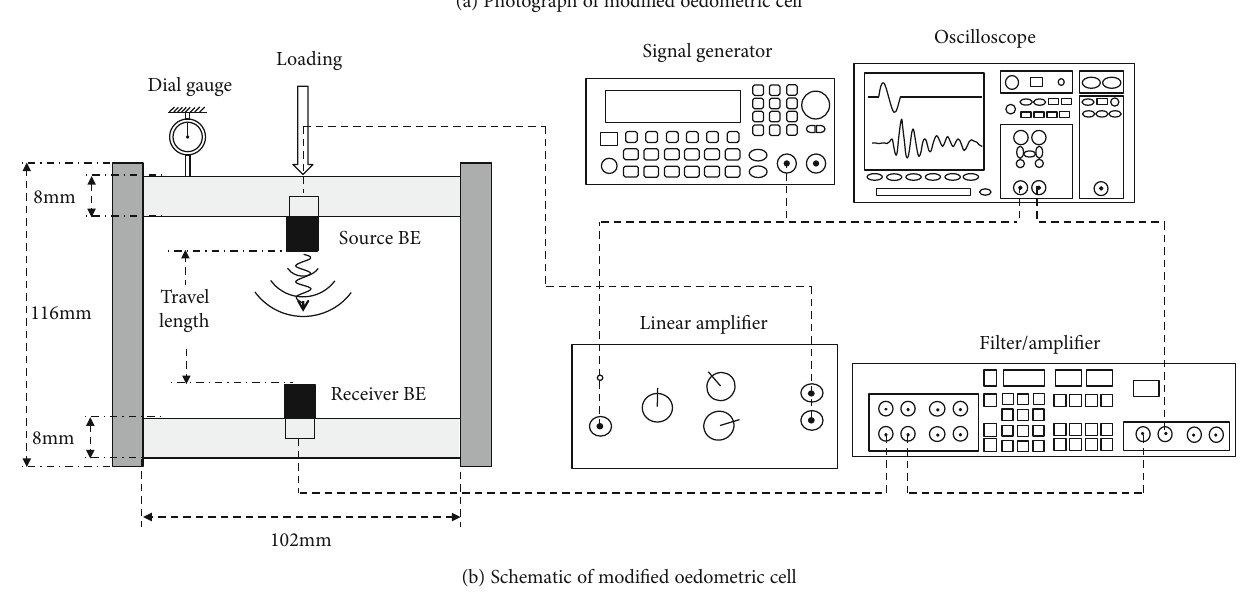
Figure 1: Details of modi fi ed oedometric cell and experimental